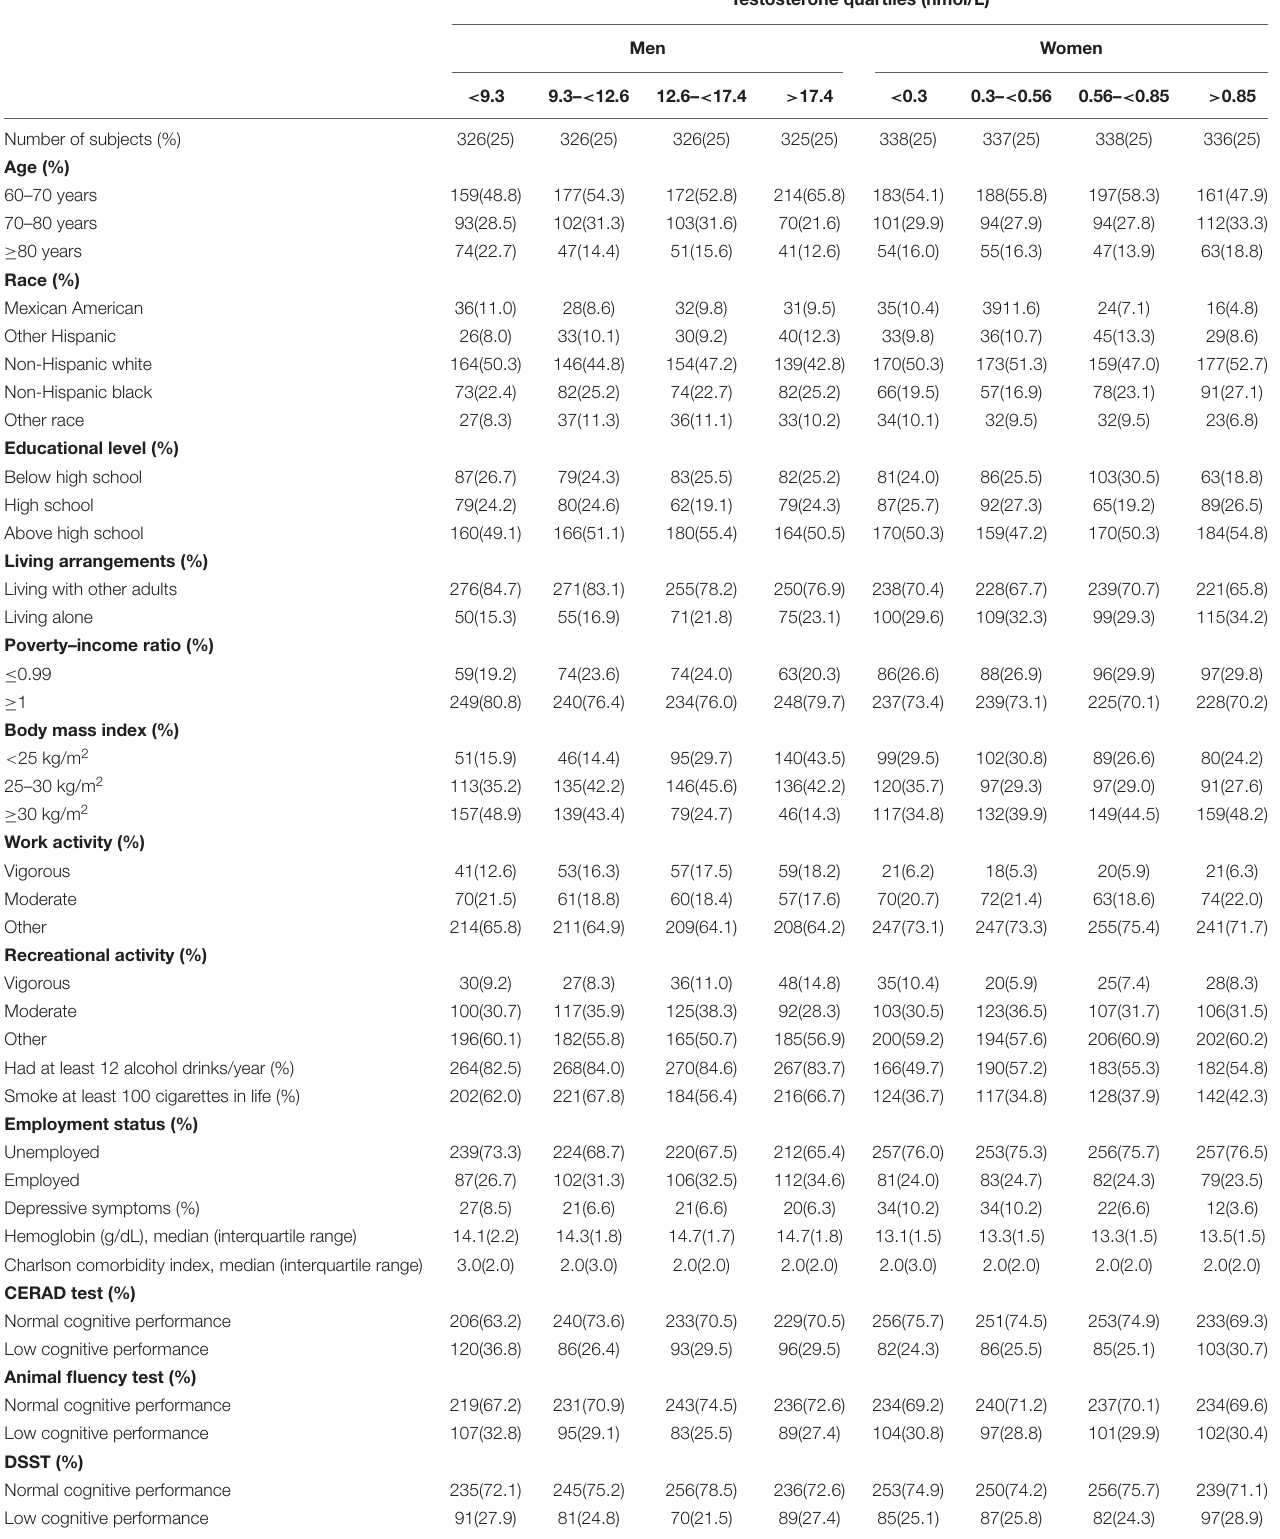
TABLE 1 | Characteristics of the study population disaggregated by quartiles of total testosterone, NHANES 2011–2014 ( N =